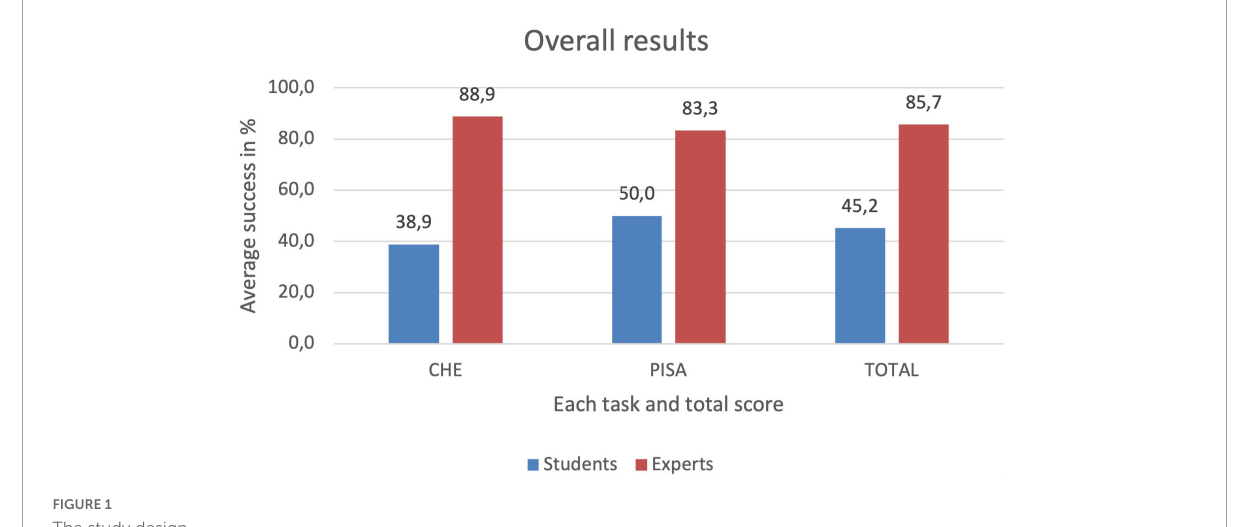
FIGURE1 The study